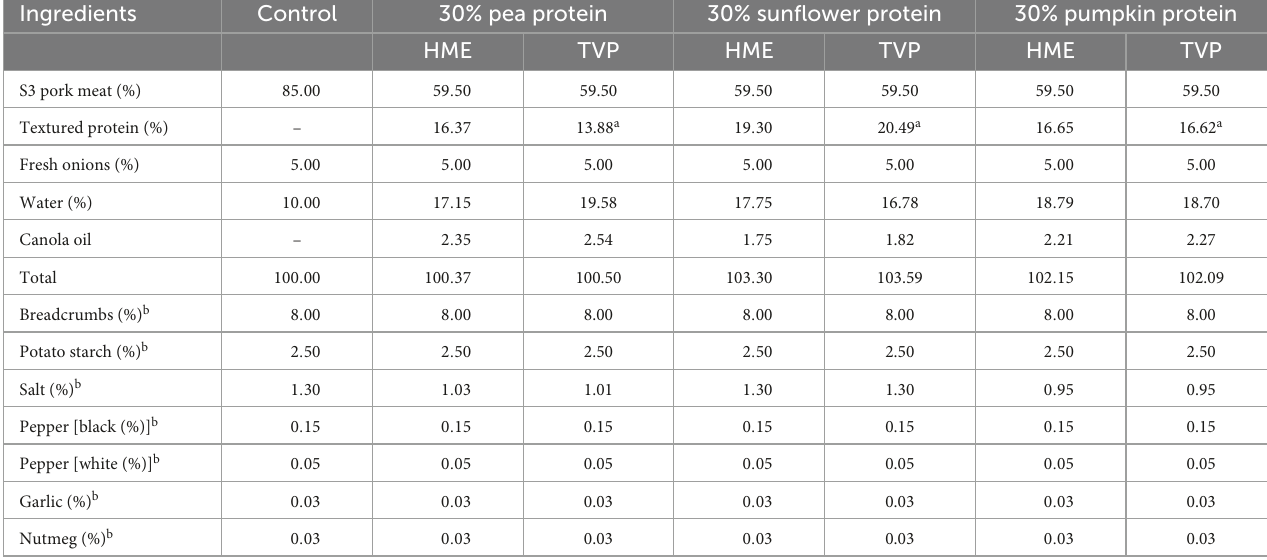
TABLE 1 Recipe for each (hybrid) meatball type [Reprinted from Baune et al. (7)].